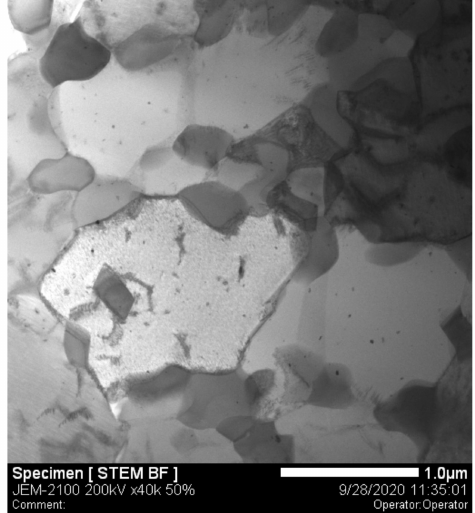
Figure 22. Ti 2 Ni grain boundary precipitates in TiAl6V4 + Cu powder after friction stir